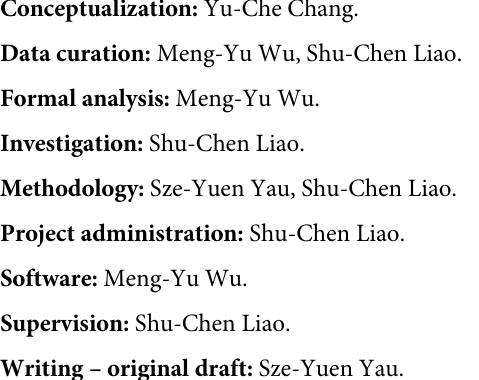
S1 Table. Time for intubation attempts and peak force applied on incisor and tongue across seniority using different devices in various scenarios. Mean and 95% CI are pre-